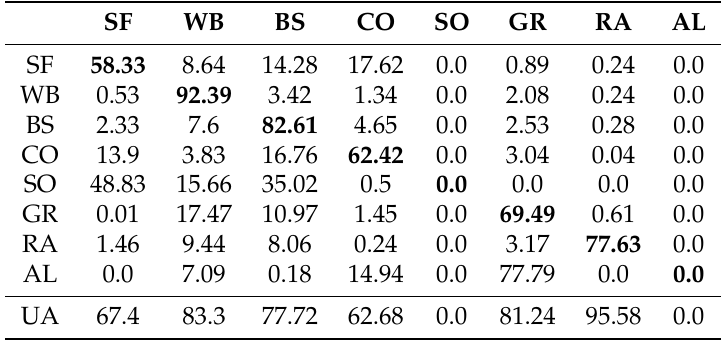
Table 14. Confusion matrix for 23-04-2015 using Sentinel-1 (7 images) and Landsat8 (9 images). κ =